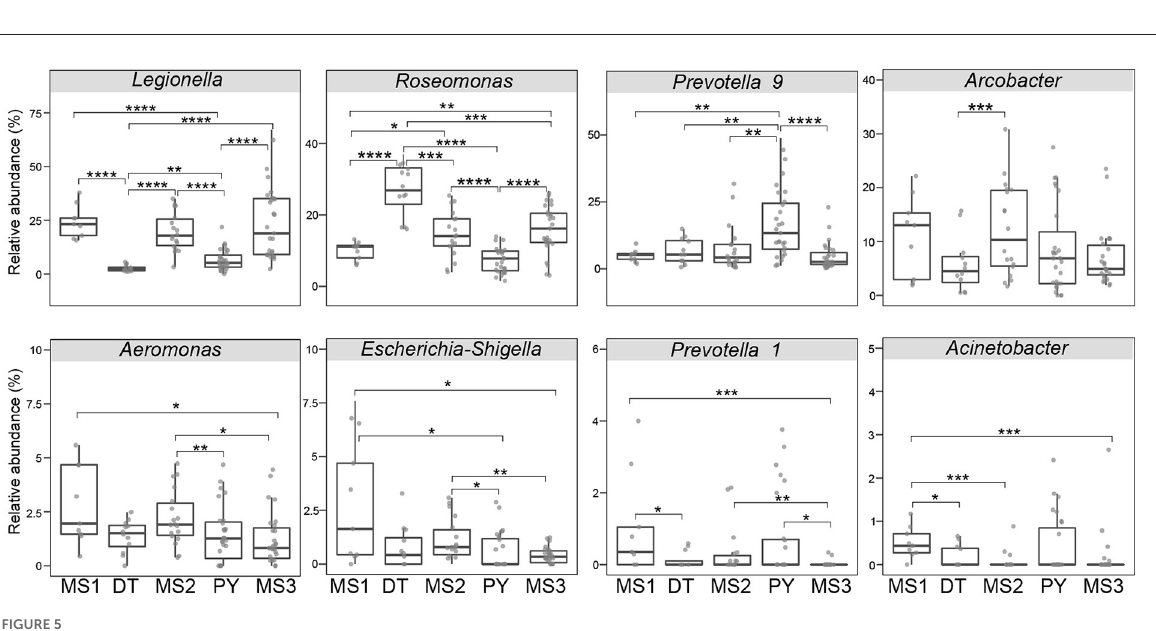
community, Chl- a ( b = 0.3), waters ( b = 0.2), TN ( b = − 0.2), Ni ( b = − 0.1) and transparency ( b = − 0.1) contributed the larger partial regression coefficient, with other